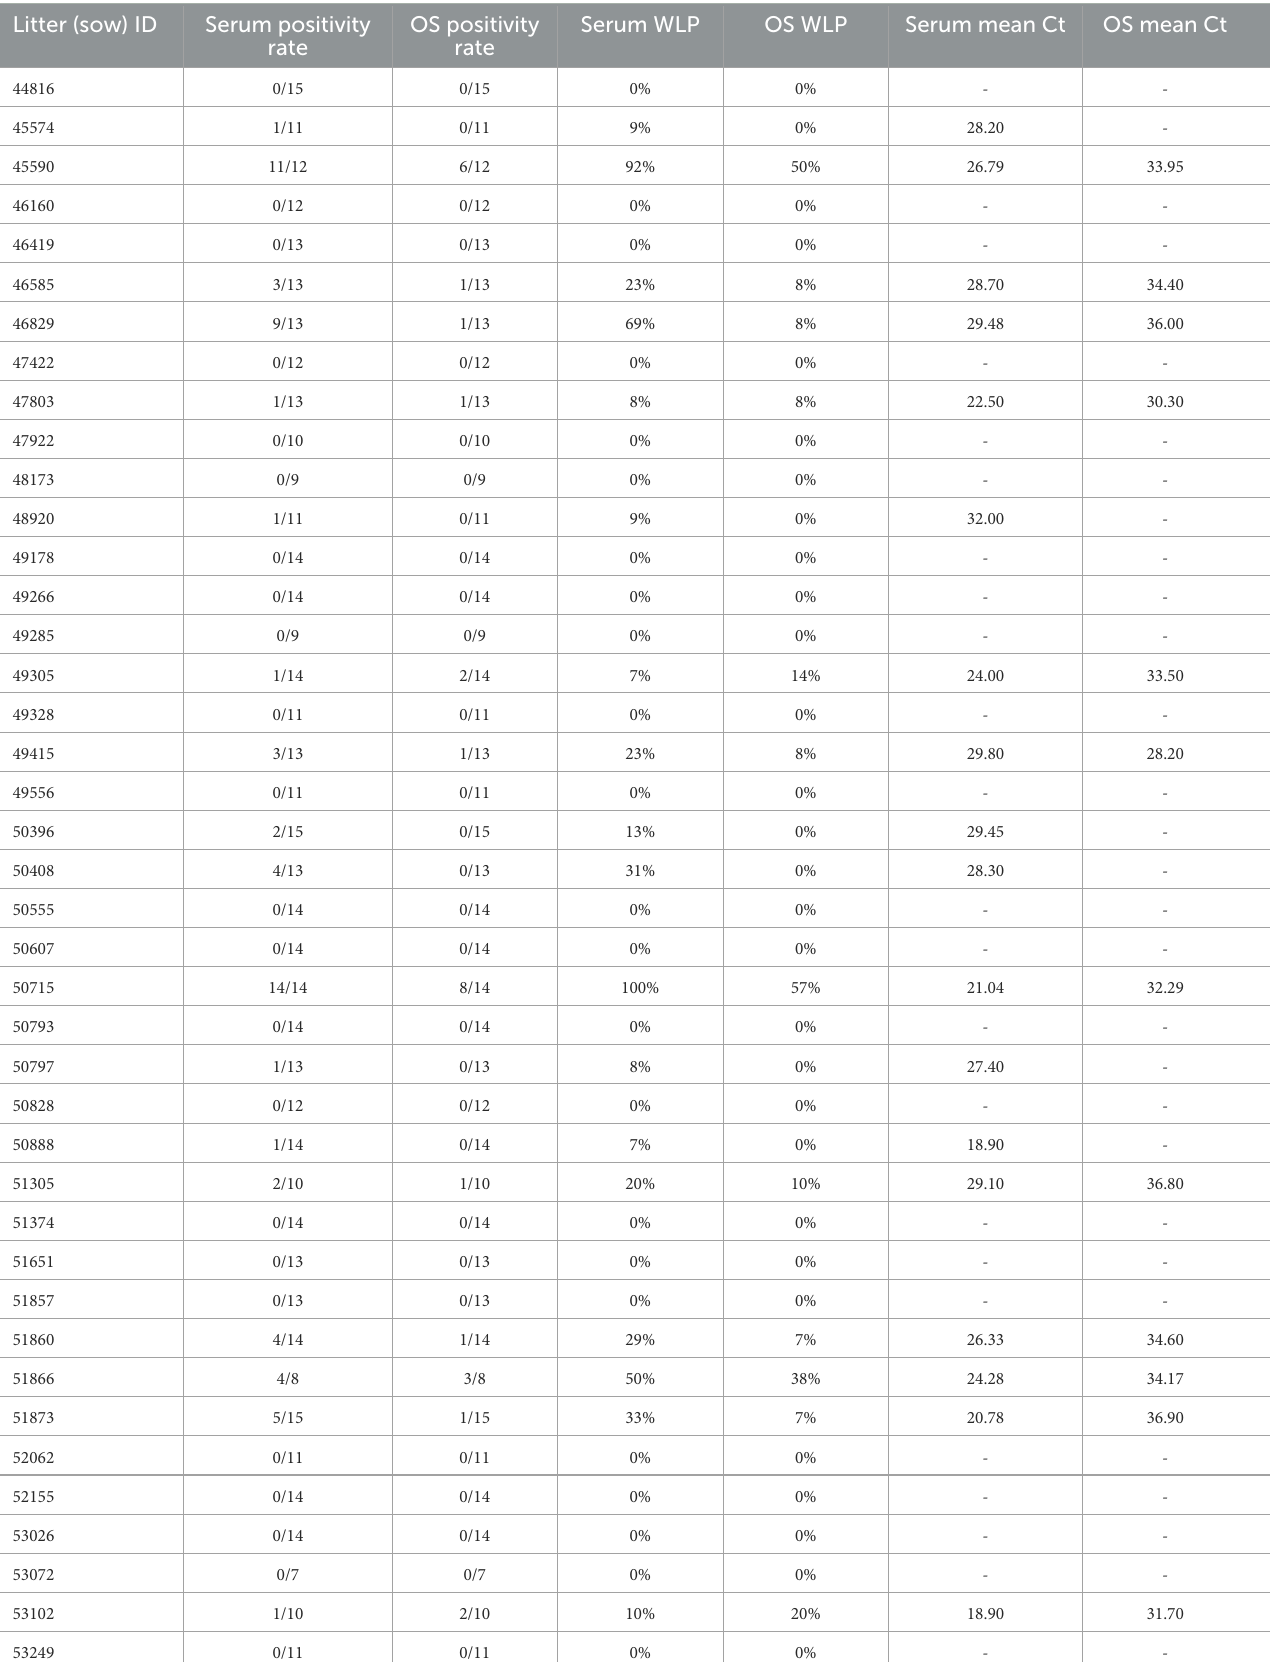
TABLE 2 Within-litter prevalence (WLP) and mean cycle threshold values for serum and oral swab (OS) sample types for each litter sampled. Litter (sow)